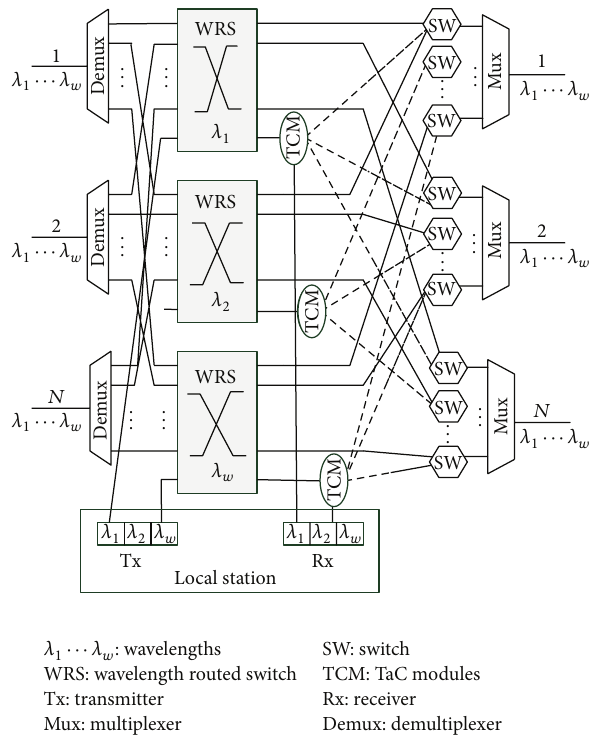
Figure 1: Optical switching node architecture with TaC.